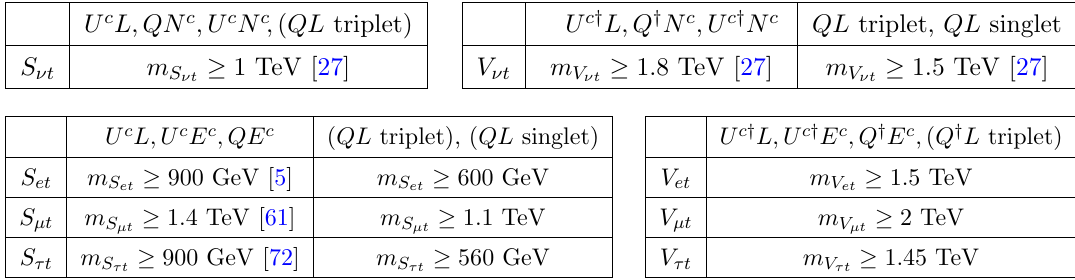
Table 7. 95% CL lower limits on the masses of MLQs which decay into ( lt )( lt ) (cid:12)nal states with l = (cid:23); e; (cid:22); (cid:28) for scalar leptoquarks ( left ) and vector leptoquarks ( right ). The recasted bounds (bounds without references) are obtained using the (cid:22) -factor scaling described in [5]. given